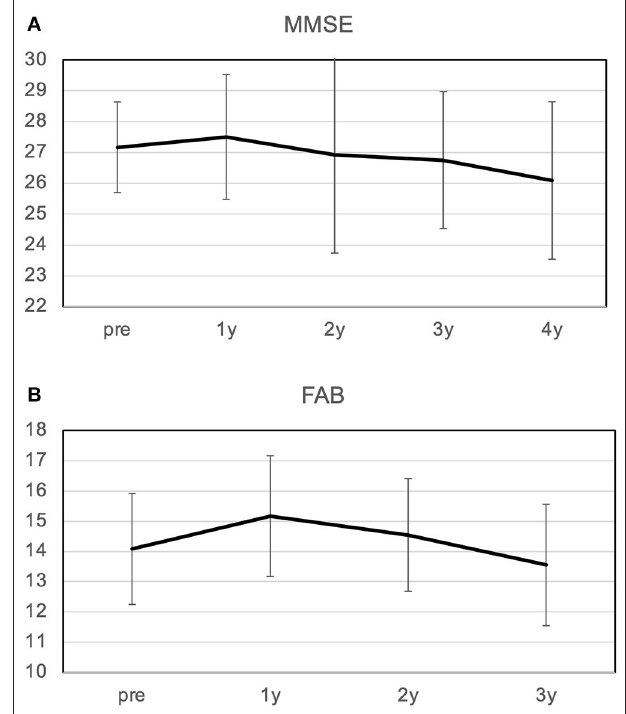
FIGURE 2 | Changes in MMSE (A) and FAB (B) over 4 years. (A) The MMSE improved from 27.2 to 27.5 at 1 year postoperatively and then declined slowly; the average rate of decline over 4 years was 0.26/year. (B) FAB improved from 14.1 to 15.2 at 1 year, and then declined slowly at a rate of 0.85/year. MMSE, Mini-Mental State Examination; FAB, Frontal Assessment